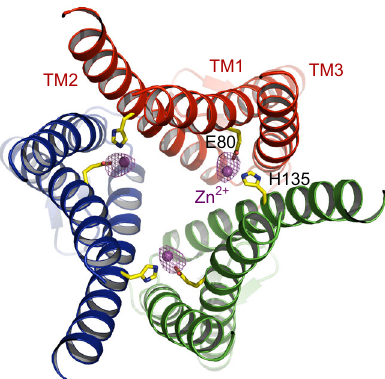
Fig. 6 Zn-binding site. sCtr1 cryst is viewed from the intracellular side. Zn 2 + ions are shown as magenta spheres and the anomalous difference electron density contoured at 6.0 σ is shown as magenta